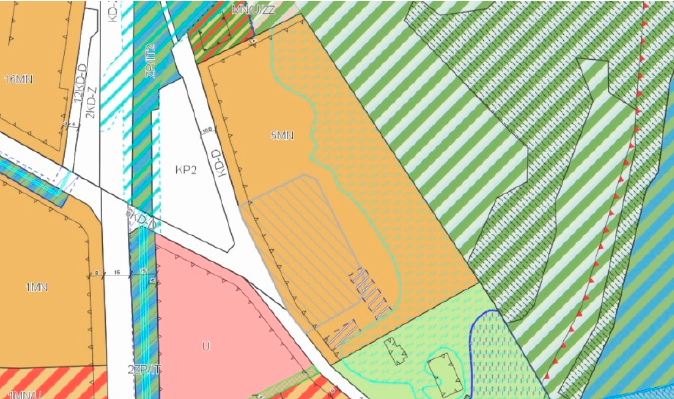
Figure 4. Image of the local plan in some areas of particular flood risk. Source: [32].